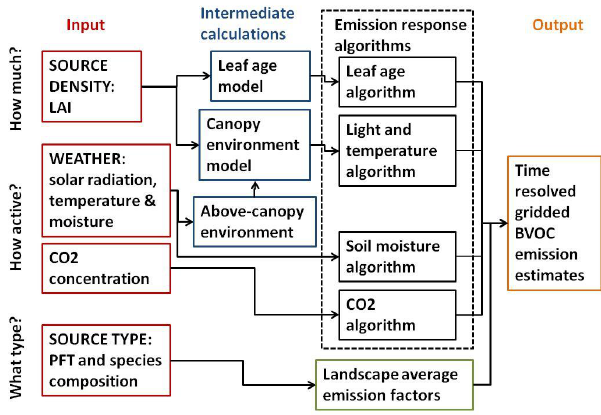
Fig. 1. Schematic of MEGAN2.1 model components and driving Figure 1. Schematic of MEGAN2.1 model components and driving variables.